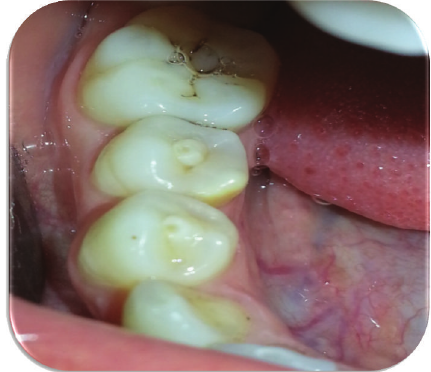
Figure 4: Placement of calcium hydroxide (Metapex) intracanal medication.